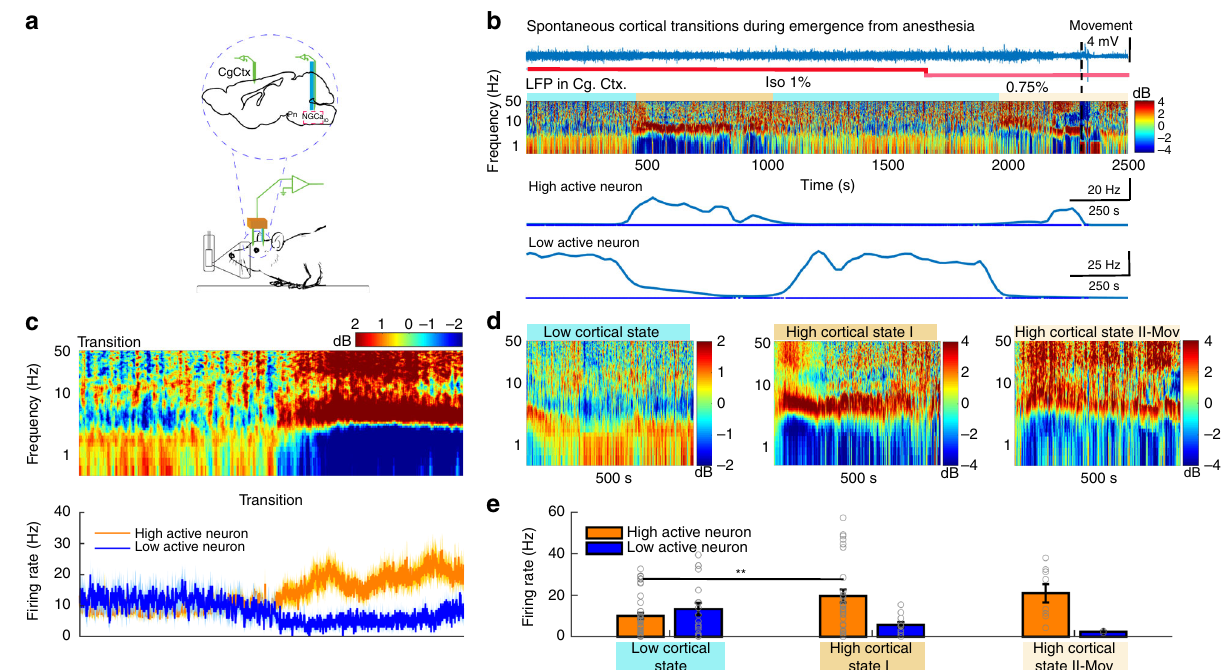
Fig. 5 Synergistic activity of aNGC neurons promotes emergence from anesthesia. a Schematic shows experimental con fi guration and location of electrodes in the cingulate cortex (Cg Ctx) and aNGC (nucleus gigantocellularis) to record LFPs and single units during emergence from anesthesia. b Representative trace of raw LFP recorded in the cingulate cortex (top) and normalized spectrogram (deviation from mean) showing the predominant frequencies observed during the transition between a coma-like state and wakefulness under iso fl urane concentrations of 1% and 0.75% until the onset of movement (dashed lines). Color bar represents power in decibels. Bottom panel shows the average fi ring rate observed in a representative HA and LA neuron simultaneously recorded as the animal emerges from anesthesia. c Displays the average spectrogram during the transition from low to high states ( n = 14; 100 s before and after transition) and the average fi ring rate (error in light colors) of HA and LA cells located in aNGC. d Average spectrogram of detected states, low state ( n = 17), high cortical state I ( n = 11), and high-state II-Mov ( n = 3) in six animals. e Average fi ring rate (mean± s.e.m.) from HA ( n = 6) and LA neurons ( n = 5) in low cortical state and high state I and II. HA ( n = 8) and LA ( n = 3); nonparametric analysis; Kolmogorov – Smirnov ** p < 0.01. Source data are provided as a Source Data fi